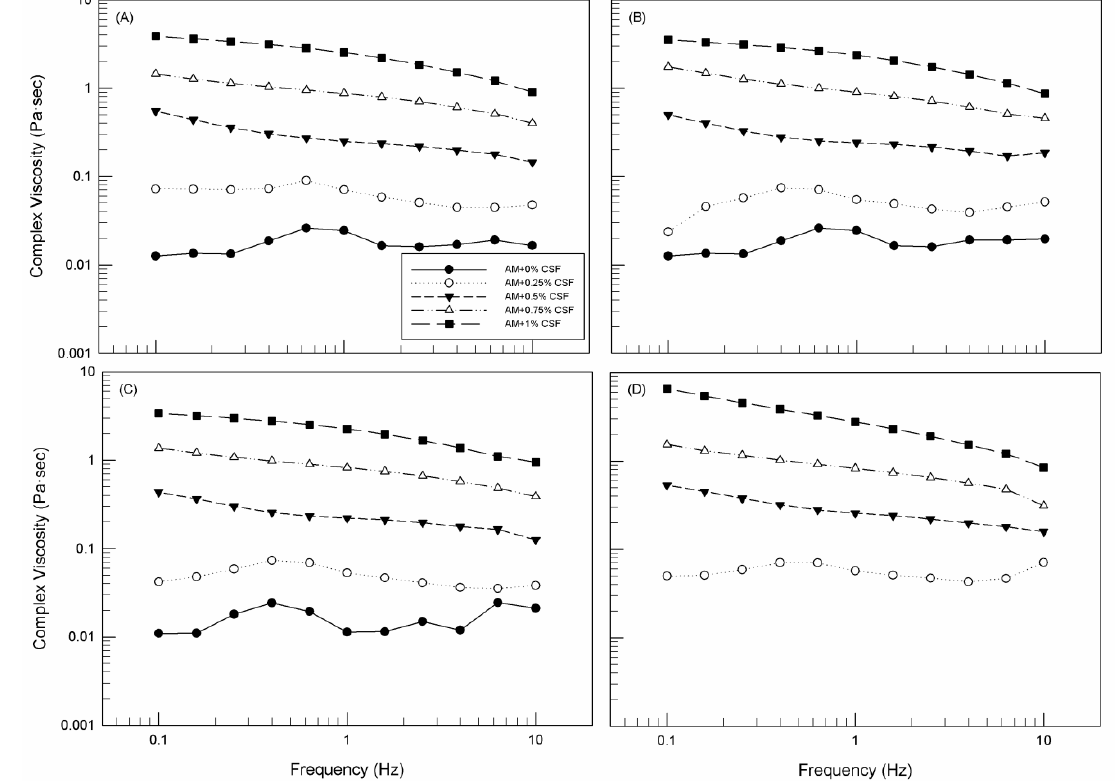
Figure 3. Complex viscosity (Pa·sec) versus frequency (Hz) for yogurt-like structures made of almond milk and increasing concentration of carob seed flour. The samples were analyzed at time 0 ( A ), 24 h ( B ), 48 h ( C ) and 5 ( D ) days of storage. The illustrated results were representative of three independent experiments.